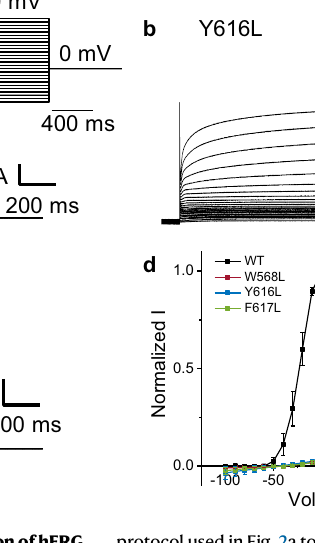
protocolusedinFig.2atoaccountfortheshifts. d Thepeakcurrentnormalizedby its maximum plotted against the membrane voltage. Data are presented